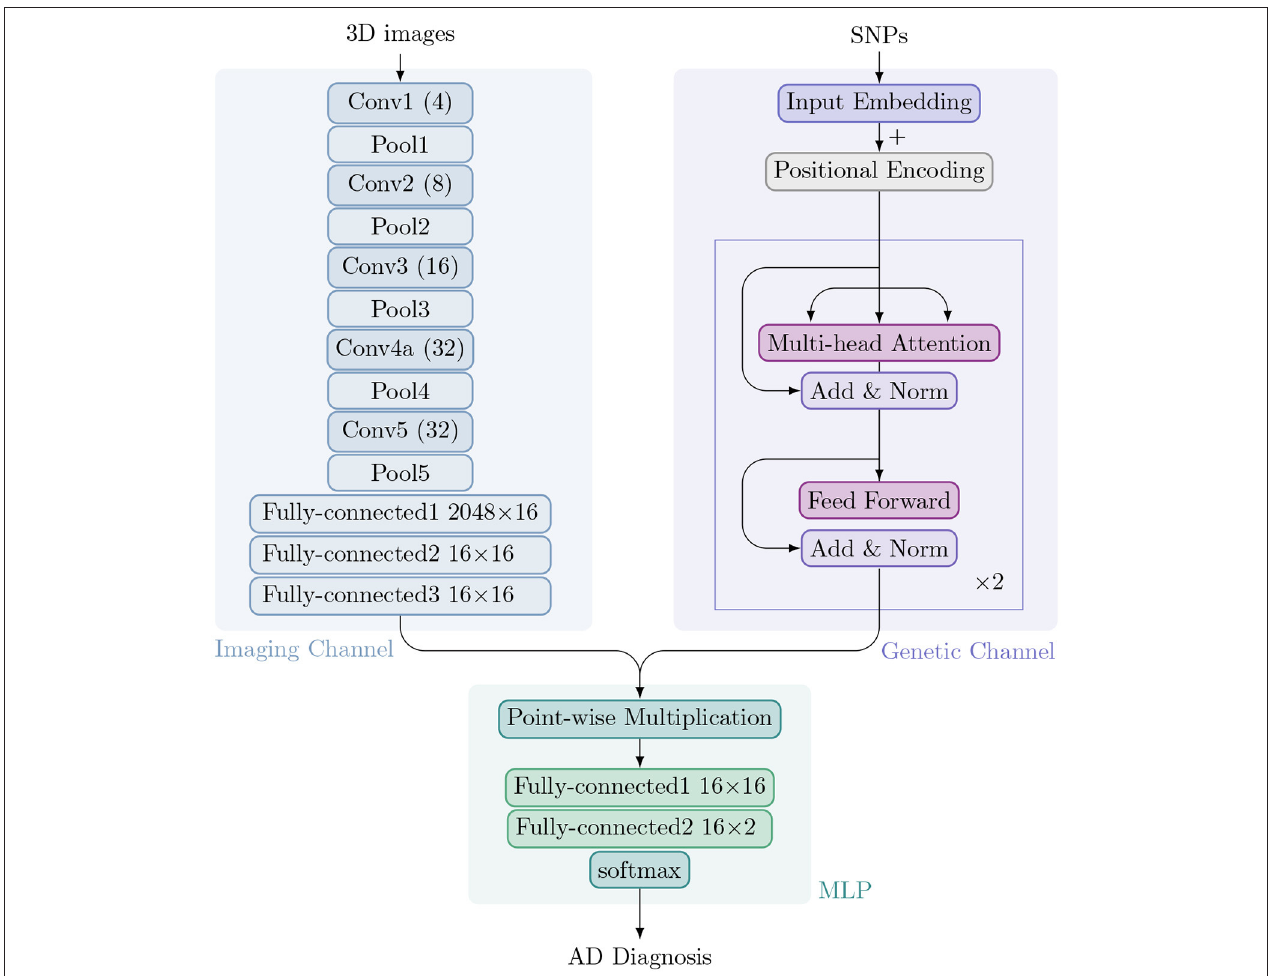
FIGURE 1 | Architecture of IGnet. Upper left: The imaging channel with a 3D CNN. Upper right: The genetic channel with a Transformer encoder. Bottom: The MLP with two fully connected layers followed by softmax.